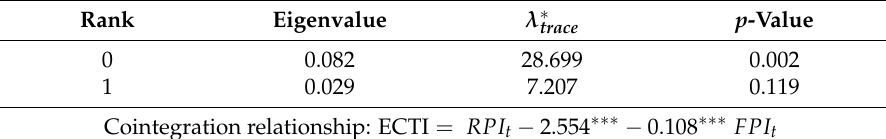
Table 4. Cointegration analysis for PDO cheese. Rank